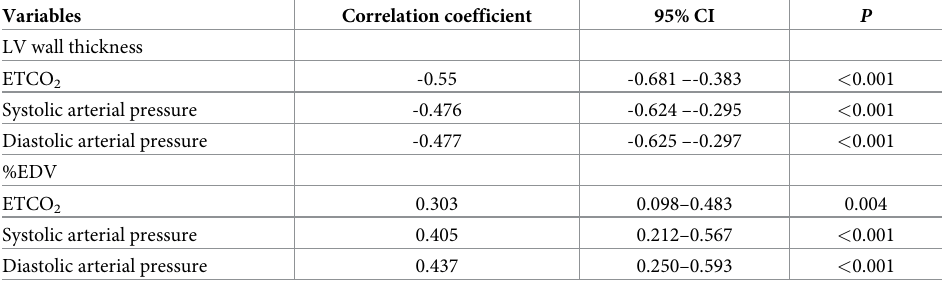
Table 2. Correlations between repeatedly measured